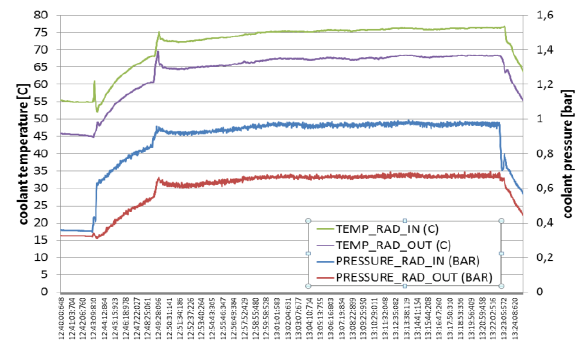
Fig. 4. Temperature and pressure of coolant measured before and after the liquid cooler